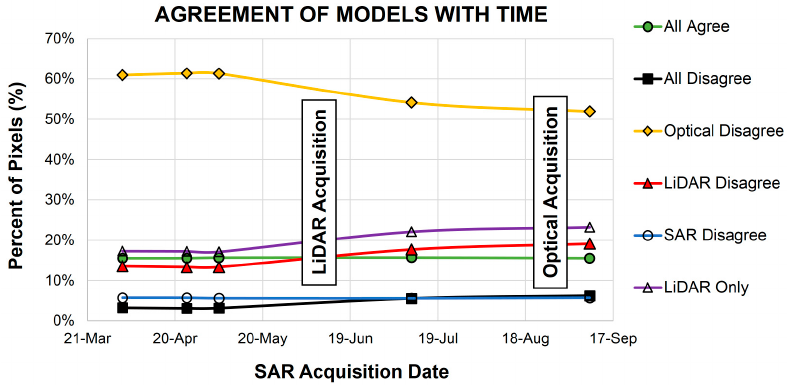
Figure 14. Percent of pixels of the five outcomes from the sensor agreement models and the LiDAR only additional statement through time of SAR acquisition dates, also showing LiDAR acquisition month (June) and optical acquisition month (August).